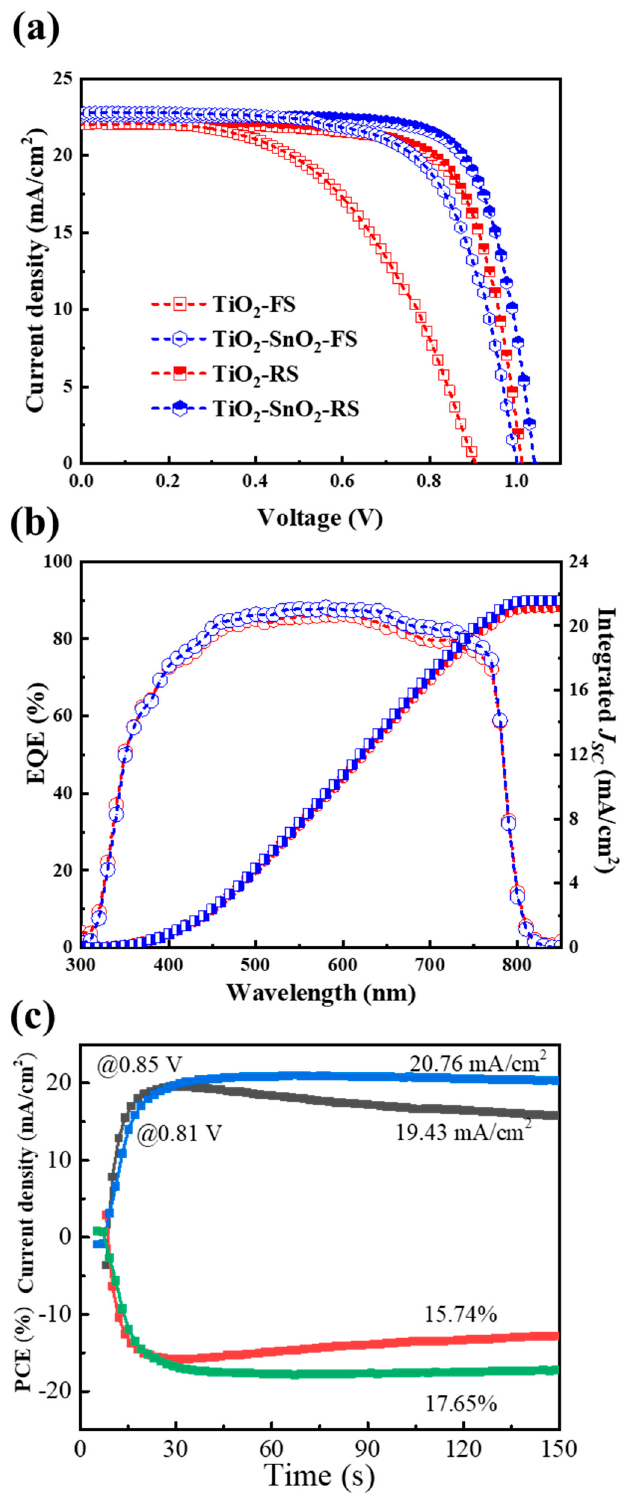
Figure 5. ( a ) Measured current density-voltage curves of champion devices. ( b ) Corresponding EQE spectra and their integrated current density. ( c ) Stable output of perovskite solar cells based on TiO 2 and TiO 2 /SnO 2 ETLs.